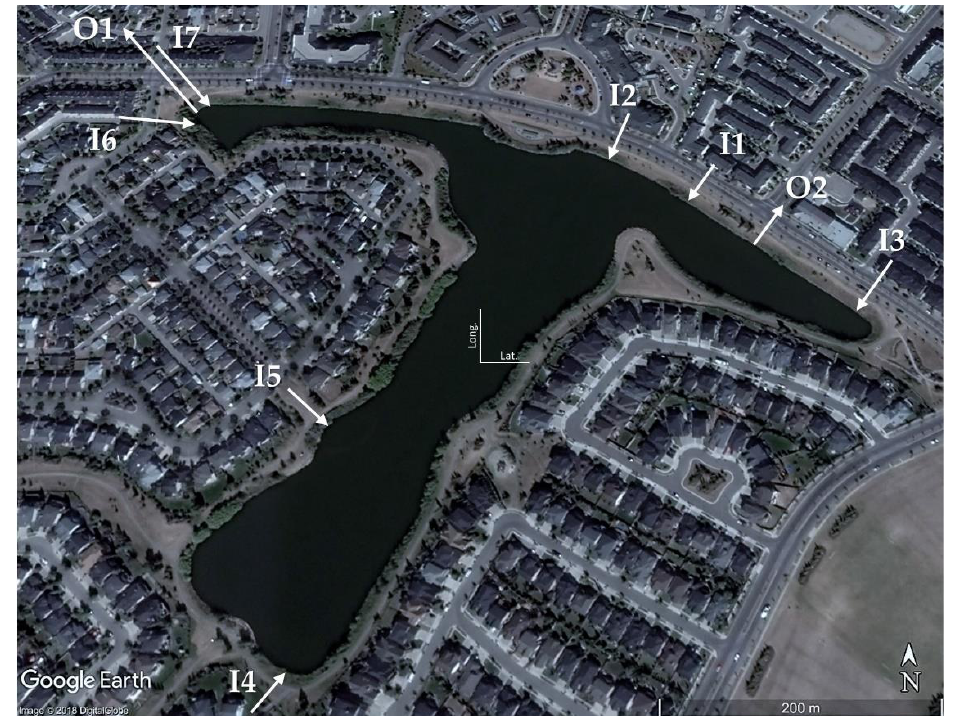
Figure 1. Arial schematic of Inverness pond showing the location of inlets and outlets (base map from Google Earth (50°54 ′ 39.4 ′′ N 113°57 ′ 46.2 ′′ W at white cross-hairs at center), arrows and texts added by author).